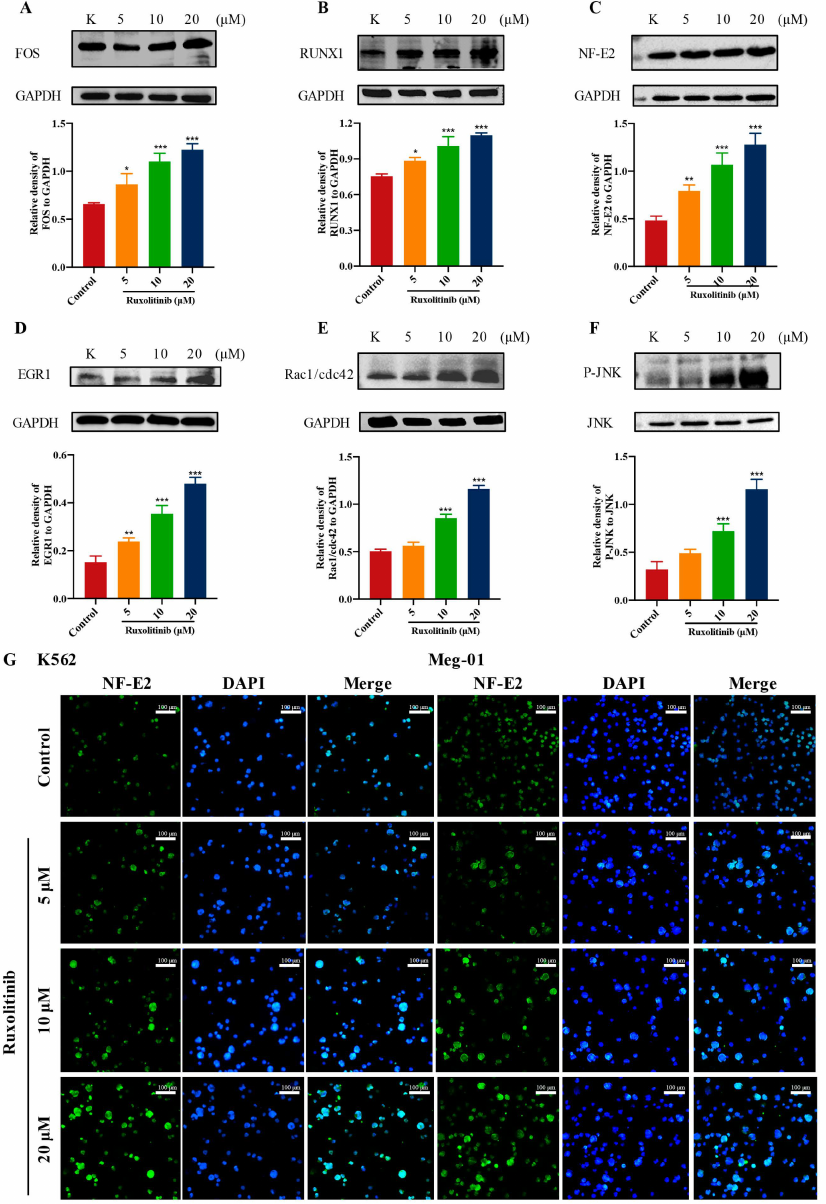
Figure 9. Expression analysis and regulate relationship of DEGs related to MK differentiation. ( A – D ) WB analysis of transcription factors related to MK differentiation in selected DEGs; ( E , F ) Rep‑ resentative immunoblot images and biochemical quantification of MKs‑affiliated pathway